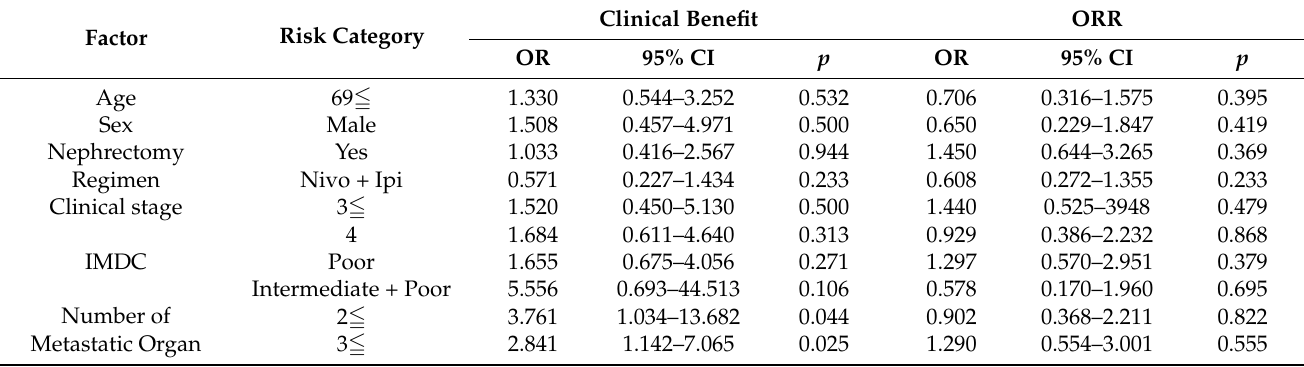
Table 3. Distributions of clinical factors and PDCD1 polymorphisms for the